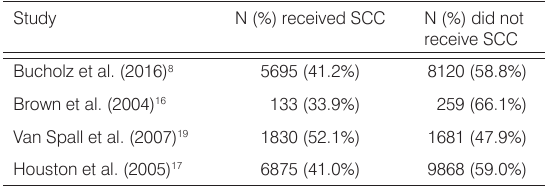
Table 1. Reported mortality rates in each